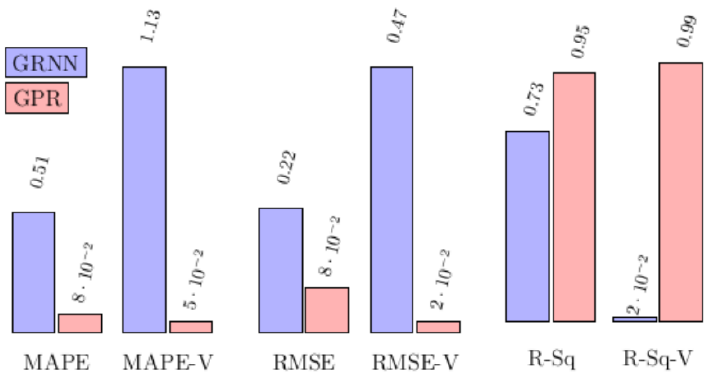
Figure 14. Comparison histogram of model characteristics for TWR.